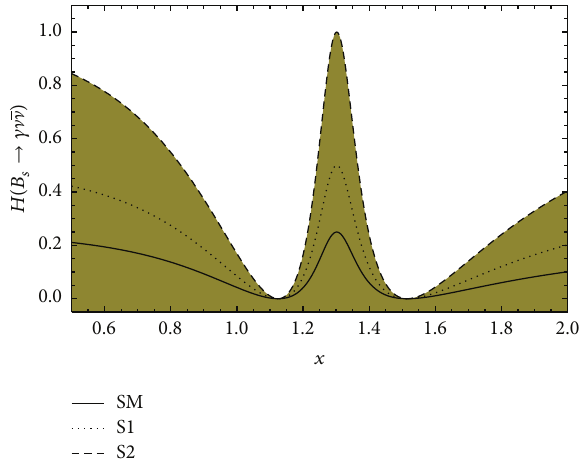
Figure 2: The dependence of the integrated photon polarization asymmetry of the 𝐵 𝑠 → 𝛾 ]]